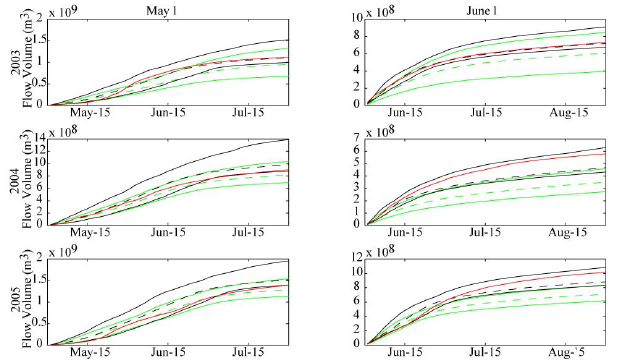
Fig. 7. Similar to Fig. 6 but for 1 May and 1 June forecasts.